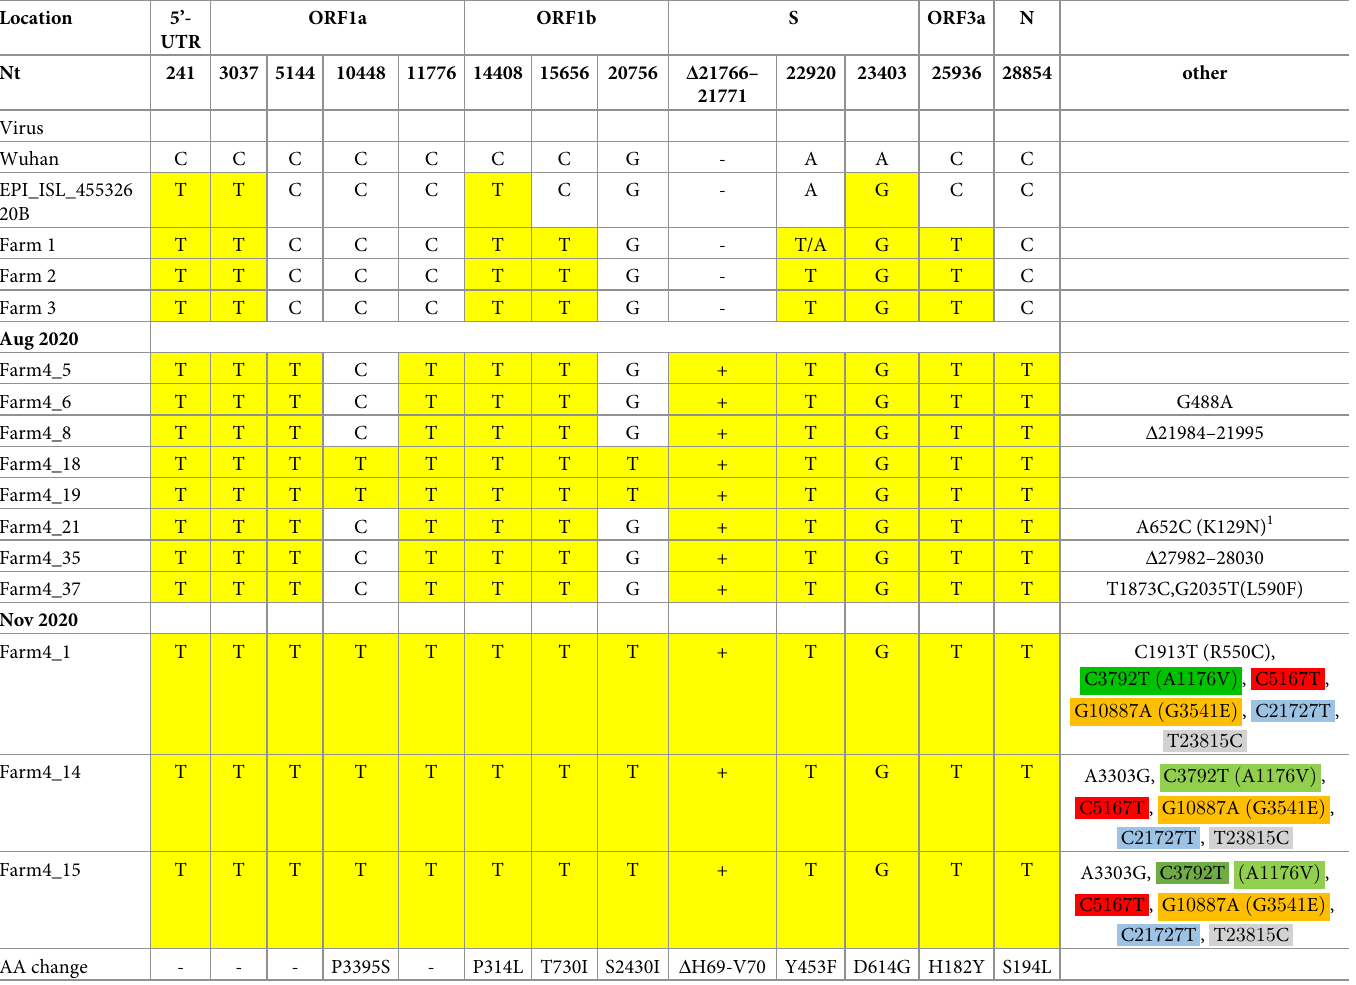
Table 2. Sequence changes within SARS-CoV-2 in mink on Farm 4.